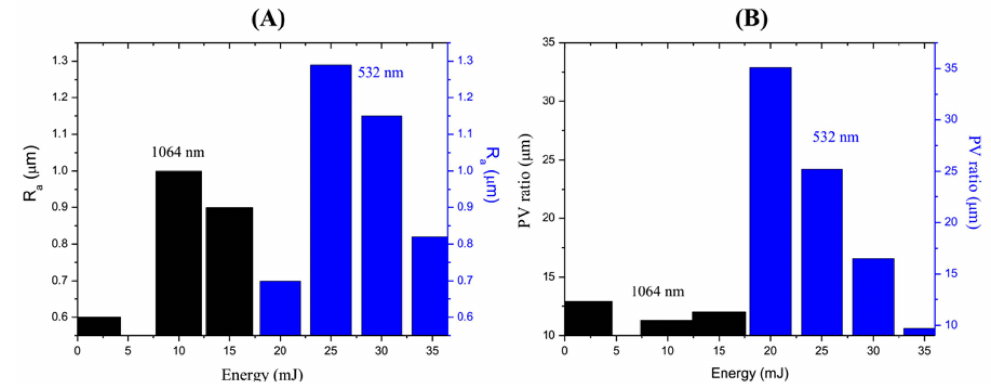
Figure 10. Diagrams of Nimonic 263 surface morphology parameters with respect to the laser energy, after 50 accumulated pulses: ( A ) average roughness ( R a ) and ( B ) peak to valley (PV)